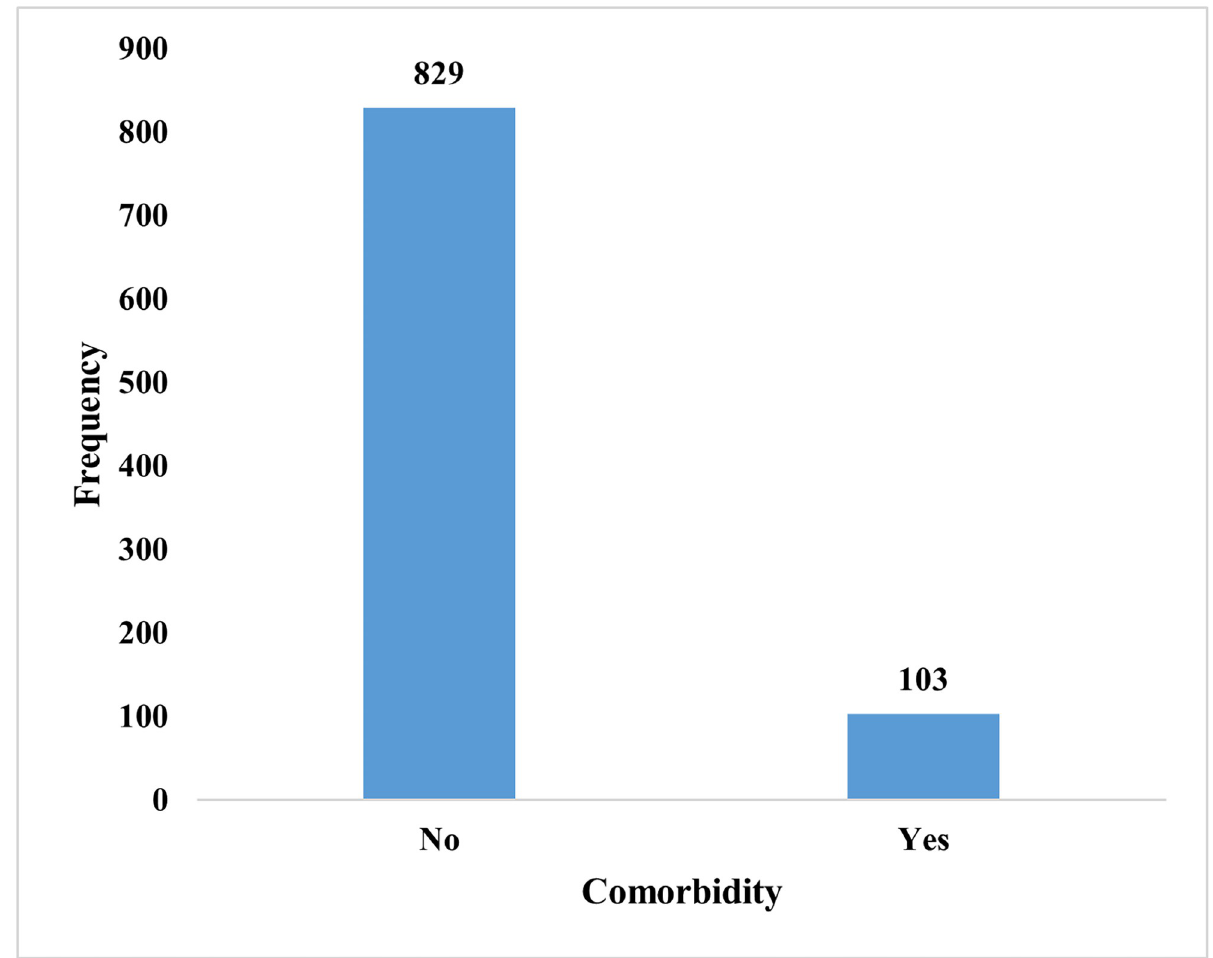
Fig 1. Comorbidity of diarrhoea and ARIs among